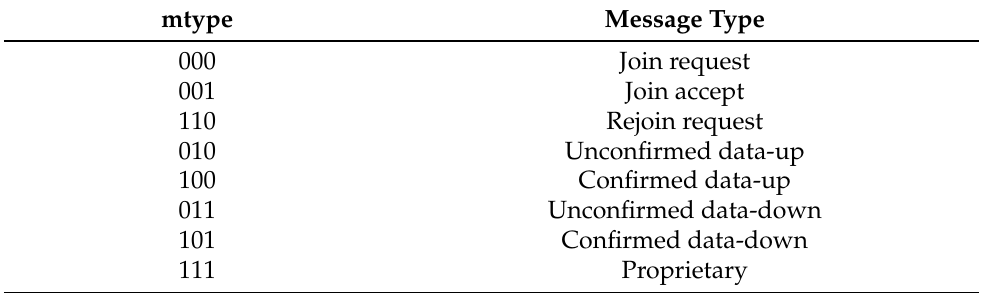
Table 2. Table reporting all mtype fields foreseen by LoRaWAN with their related message type.